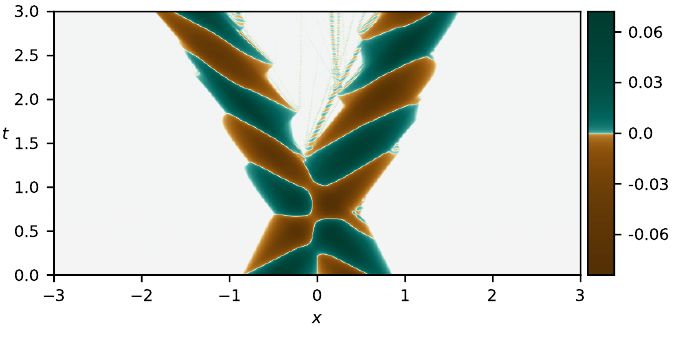
Figure 35 . Scattering process for V = 0 : 5 and (cid:11) R = 0 : 642, with parameters (cid:11) L ; v L ; v R all set to